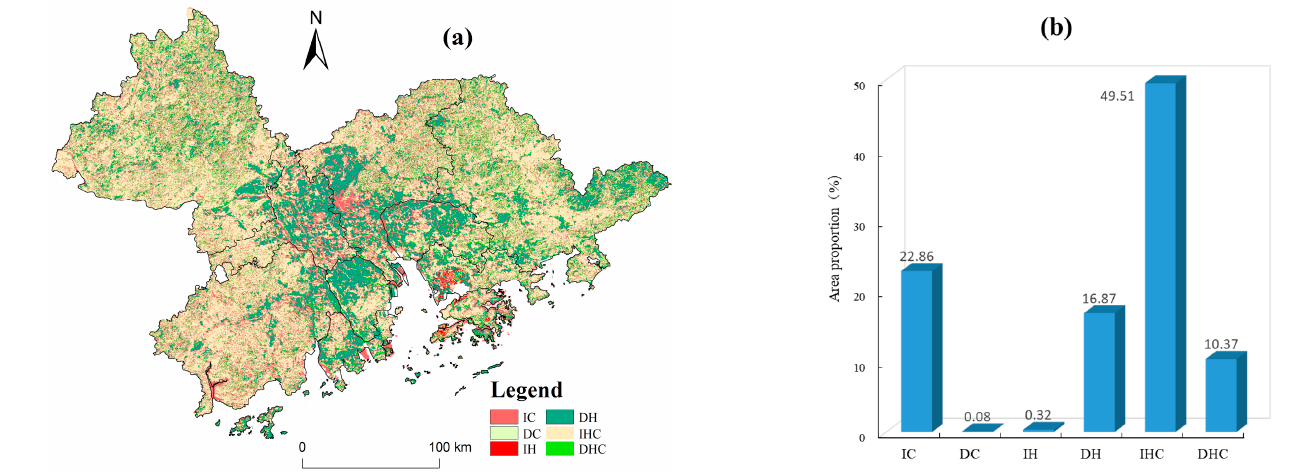
Figure 8. Spatial patterns of ( a ) six driving forces of NPP a changes from 2000 to 2020 and ( b ) area proportion. Definitions of the driving forces are given in Figure 2.